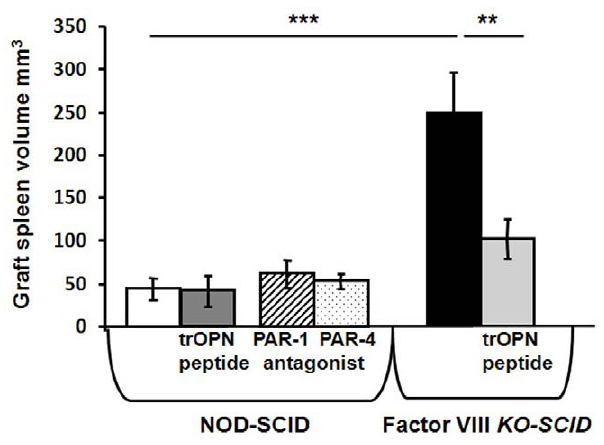
Figure 6. The role og PARS and OPN cleavage by thrombin in defining size of E42 pig embryonic spleen implants. E42 pig spleen tissue was implanted into NOD-SCID and FactoorVIII KO NOD - SCID mice and final size of the implant was defined 4 weeks after transplantation. To define the effect of PARs cleavage by thrombin, PAR-1 and PAR-4 antagonists were administered to NOD-SCID recipients as described in Methods. To evaluate the role of OPN cleavage, trOPN was administered to Factor VIII NOD-SCID recipients as described in Methods. Each group comprised 7 mice. Enhancement of growth of E42 spleen tissue in Factor VIII NOD-SCID mice compared to NOD-SCID mice was statistically significant (t test, p , 0.005)). This enhancement was significantly inhibited upon treatment with trOPN